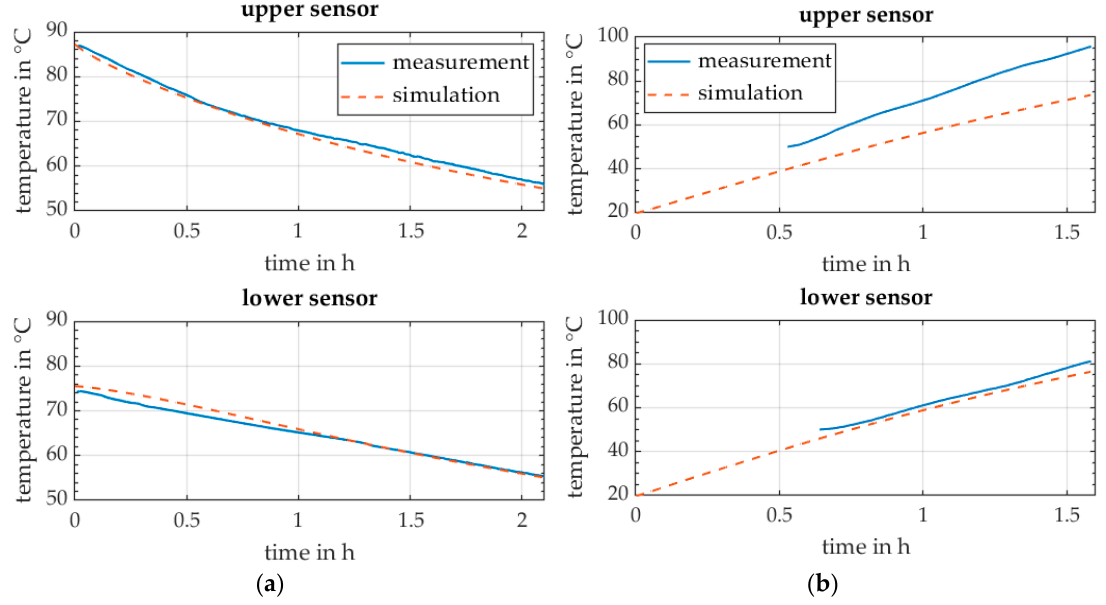
Figure 9. ( a ) Simulated and measured rotor cooling without the specimen; ( b ) Simulated and measured rotor temperatures without the specimen during cycling.